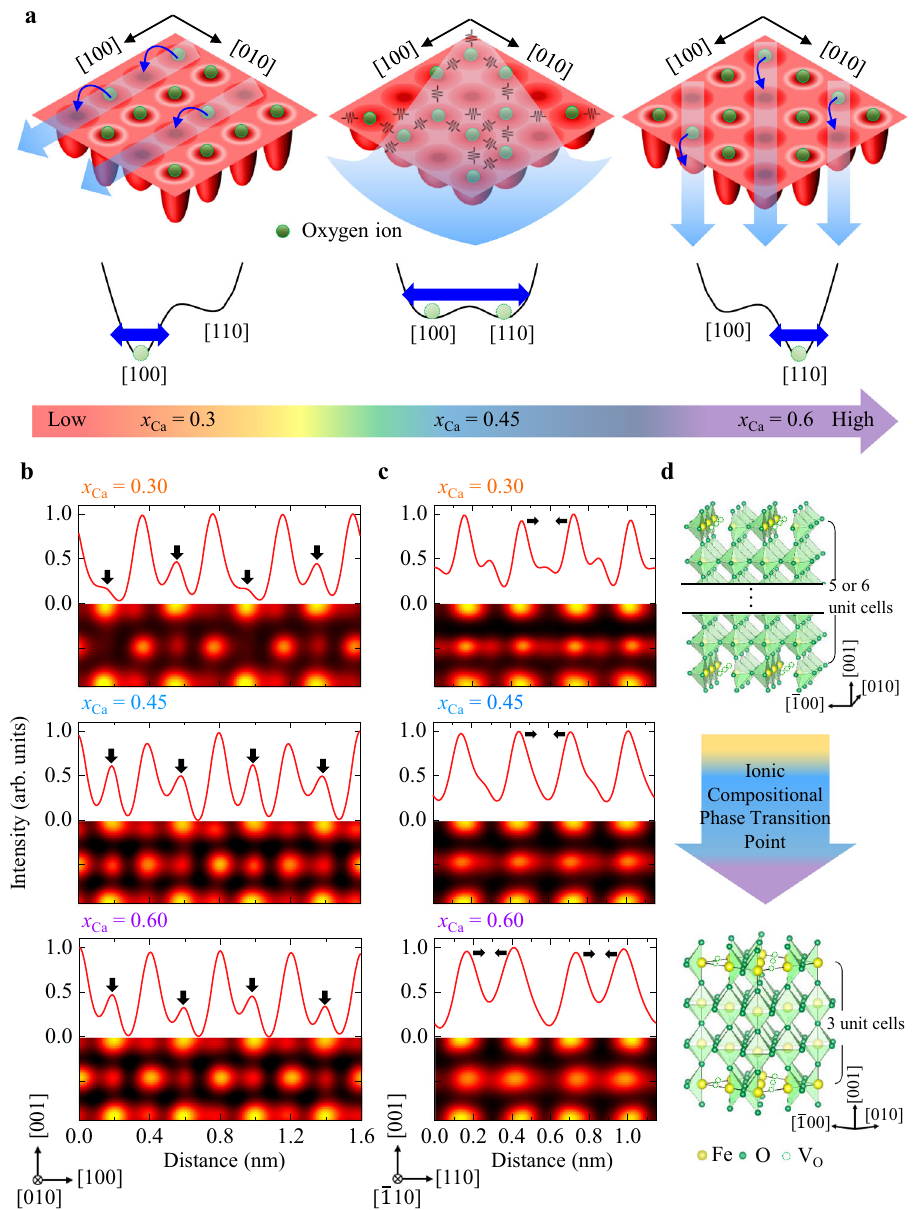
Fig. 2 | Observation of V O channels and the compositional phase transition point in BCFO fi lms. a Schematics of three types of oxygen ion migration in 2D potentials.Oxygenionsavoidresidingonthe1Datomic-scalechannelsbecausethe potential therein is not relatively deep. Ionized V O s are mainly present in the channel regions, which offer more positive potential in a self-consistent way. Free energy landscapes over the ionic con fi guration indicate competition between two types of channels along [100] or [110]. Con fi guration fl uctuations can be sig- ni fi cantly large at the phase transition point, leading to enhancement of general- ized susceptibilities such as elastic compliance and ionic conductivity. b , c RepresentativeABF-STEMimagesalong[010]([ (cid:1) 110])inthe V O layerspresentin